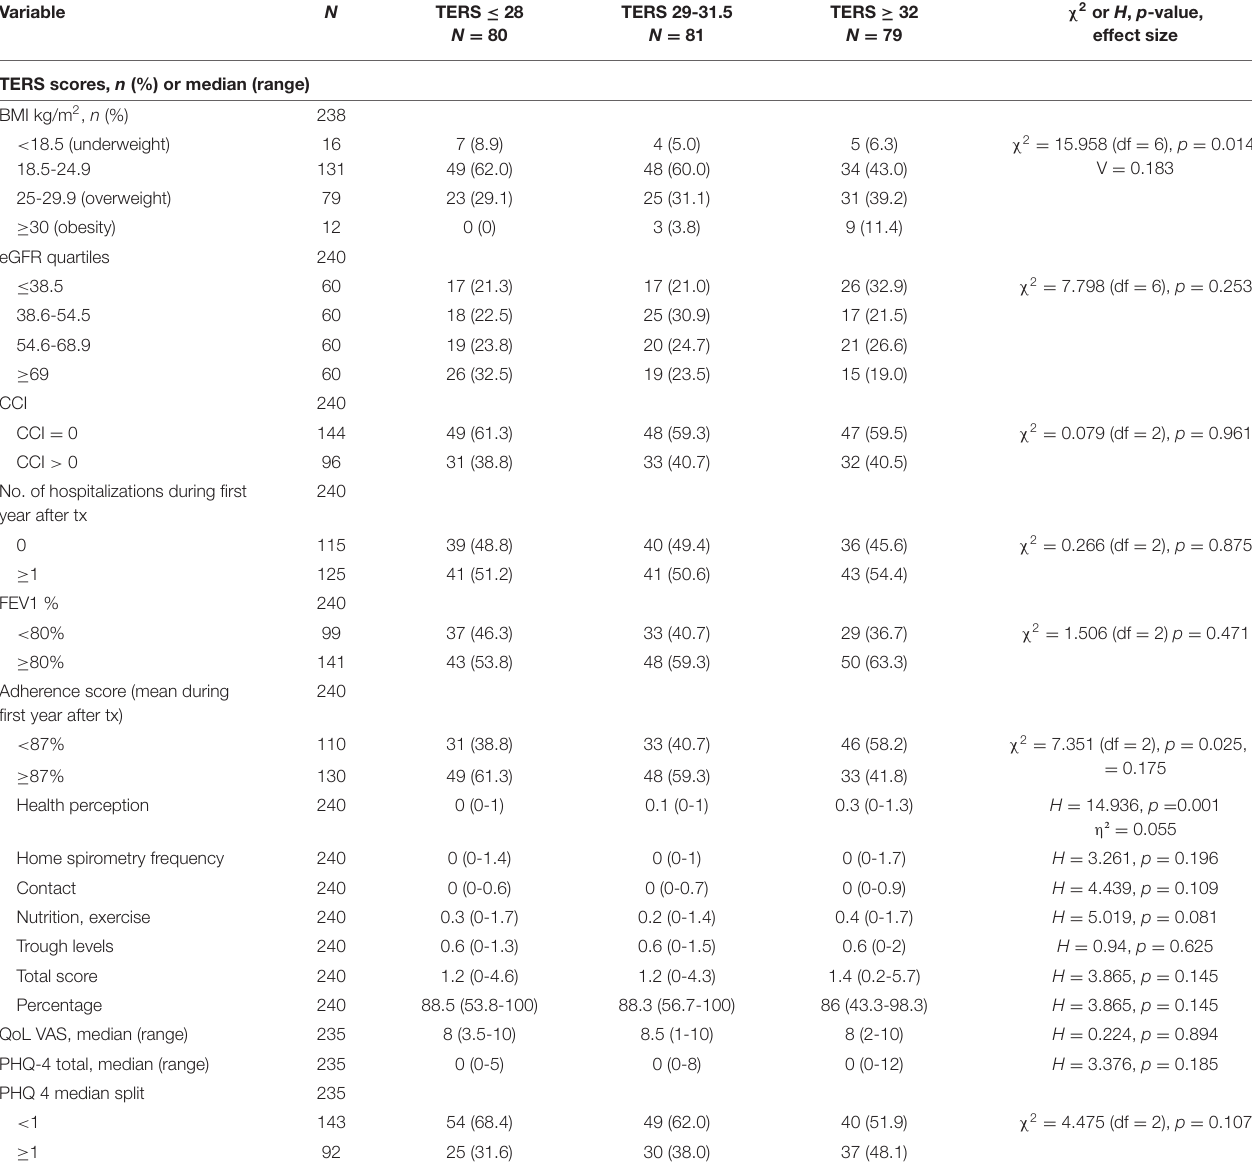
χ 2 or H , p -value, effect size